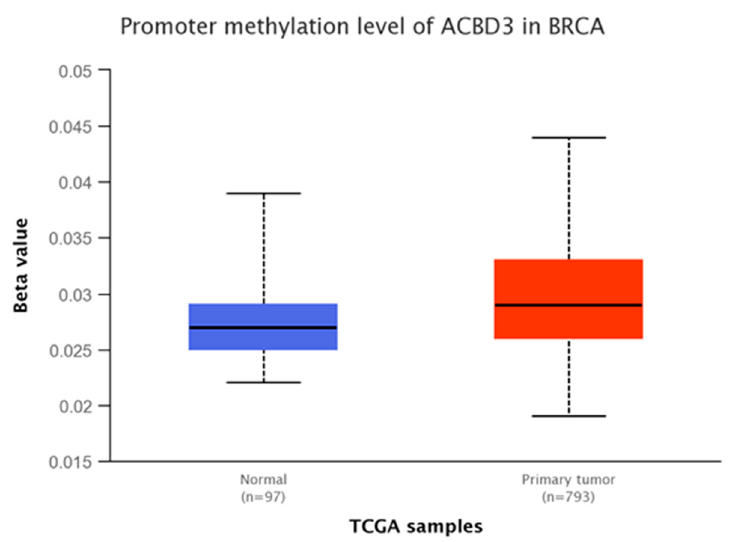
Figure 3. ACBD3 promoter methylation in normal breast tissue (blue) and breast tumor tissue (red). A low beta value represents low methylation and therefore low inhibition of transcription. A beta value below 0.3 is considered hypomethylation. ACBD3 promoter methylation was very low in both normal and tumor breast tissue with no significant difference. Gene regulation by methylation cannot account for changes to ACBD3 expression found in breast cancers.